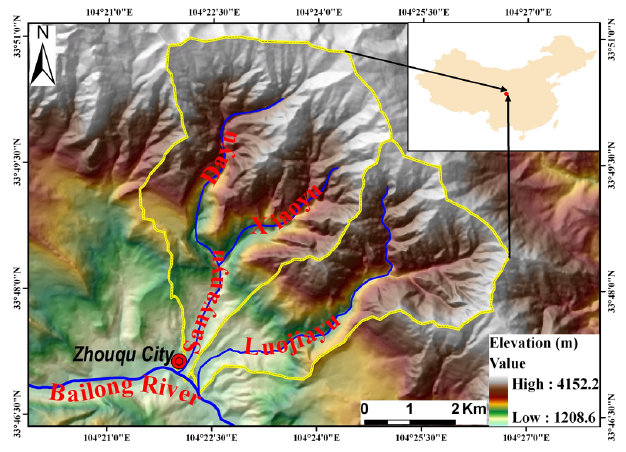
Fig. 1. Location of the study area (Dayu and Xiaoyu are two main branches of the